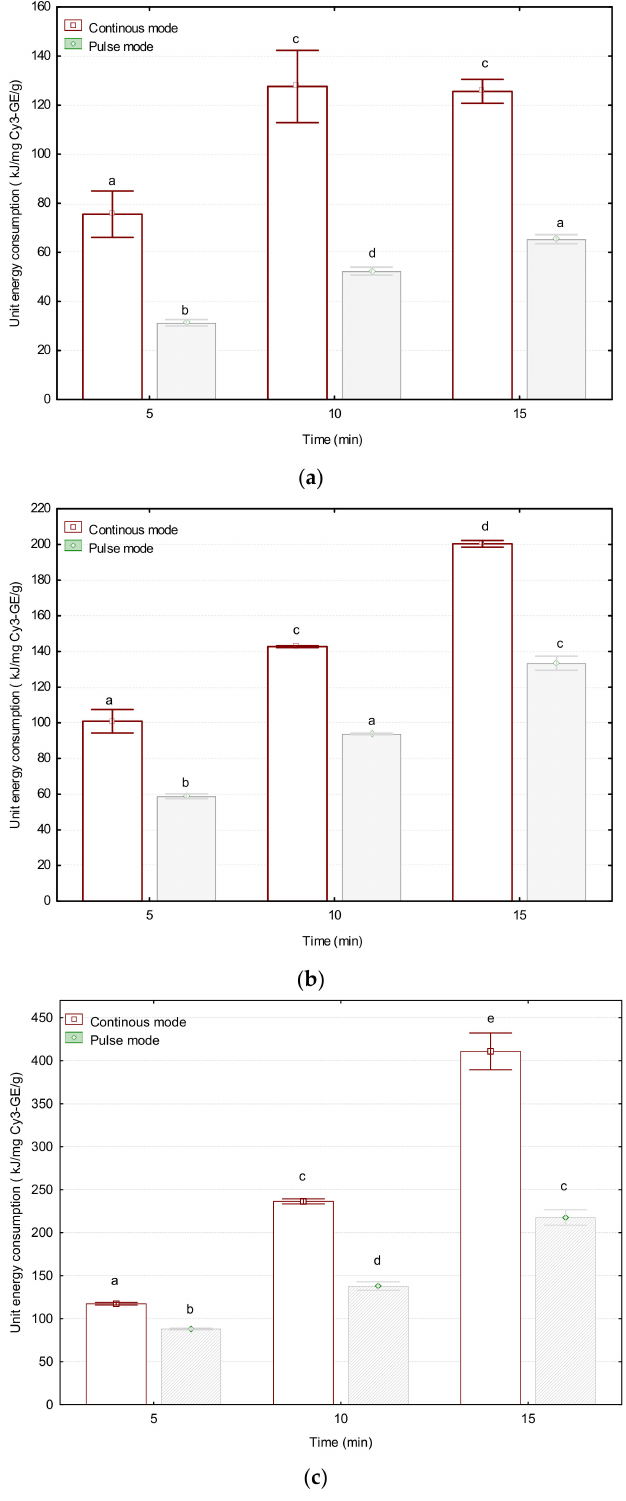
Figure 5. Impact of ultrasonic treatment parameters on the unit energy inputs during the extraction of anthocyanins from hawthorn berries: ( a ) amplitude 12 µ m, ( b ) amplitude 24 µ m, ( c ) amplitude 36 µ m. The bars marked with the same letter are not statistically significantly different ( p <